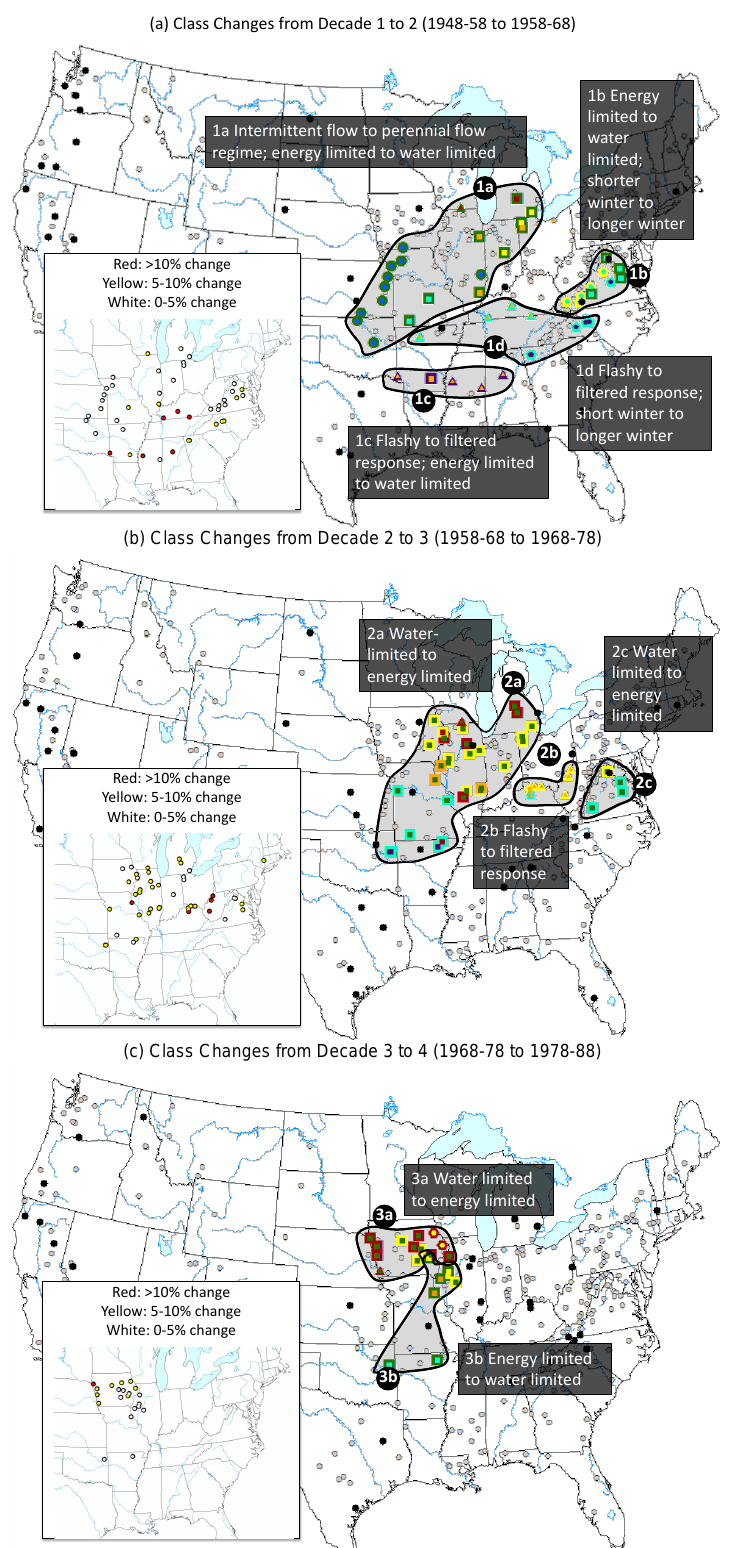
Fig. 5. Maps highlighting those catchments that change class assignment from one decade to the next, including interpretation of change. The inner color of each marker describes the initial class (see Fig. 1 for color scheme legend) and the border color describes the new class in which catchments transition during the decade under study. A catchment with a key change in S FDC is visualized as a triangle, in R SD as a pentagon, in R QP as a square, and Q 90 as a